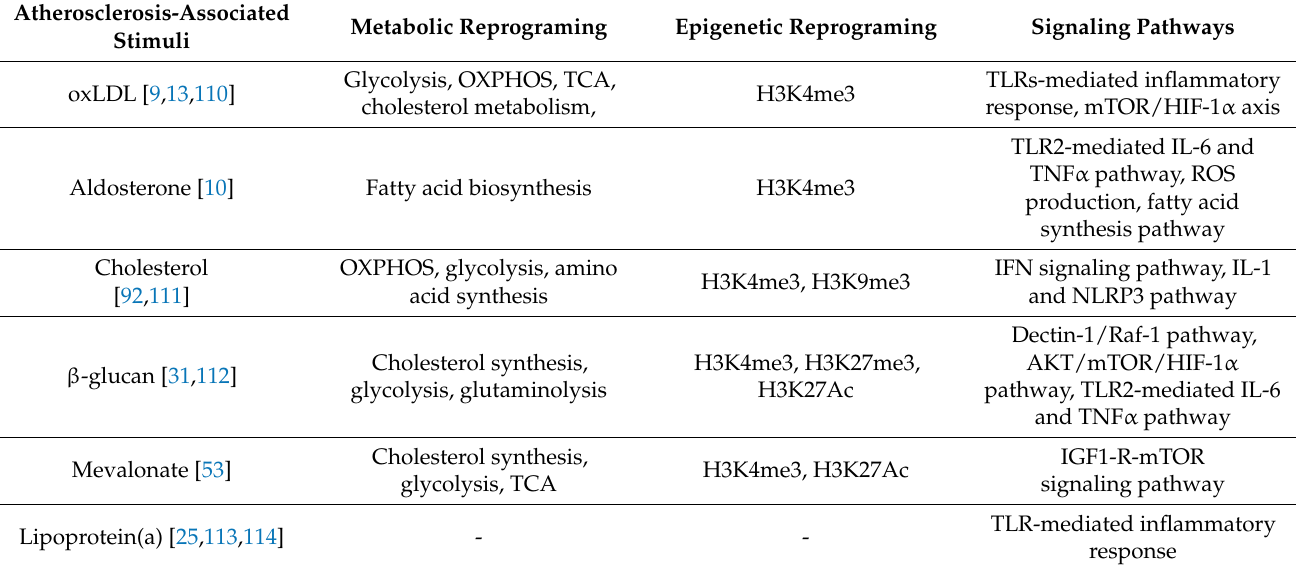
Table 2. The metabolic and epigenetic reprograming in monocytes and macrophages induced by atherosclerosis-associated